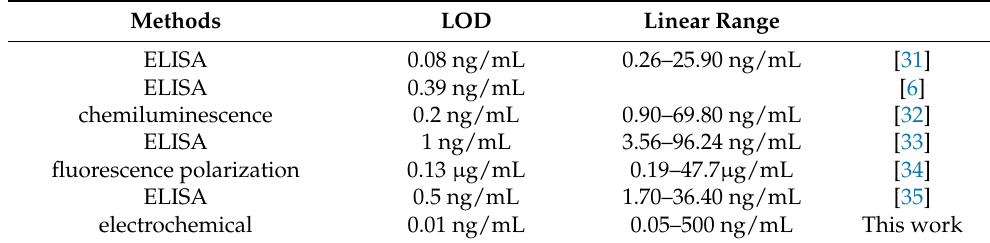
Table 2. Comparison of the proposed aptasensor with those reported in the literature.